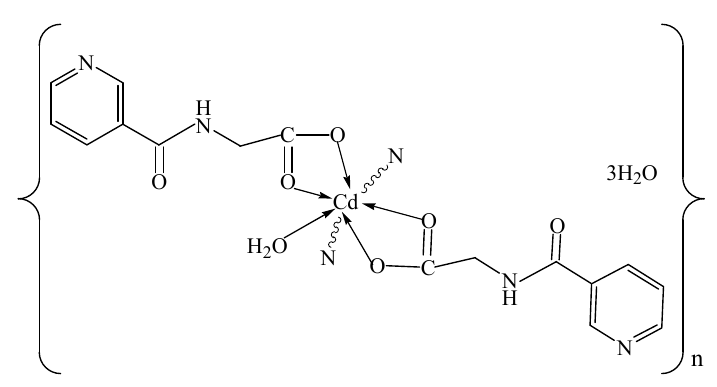
Scheme 1. Chemical diagram of the Cd(II) complex.